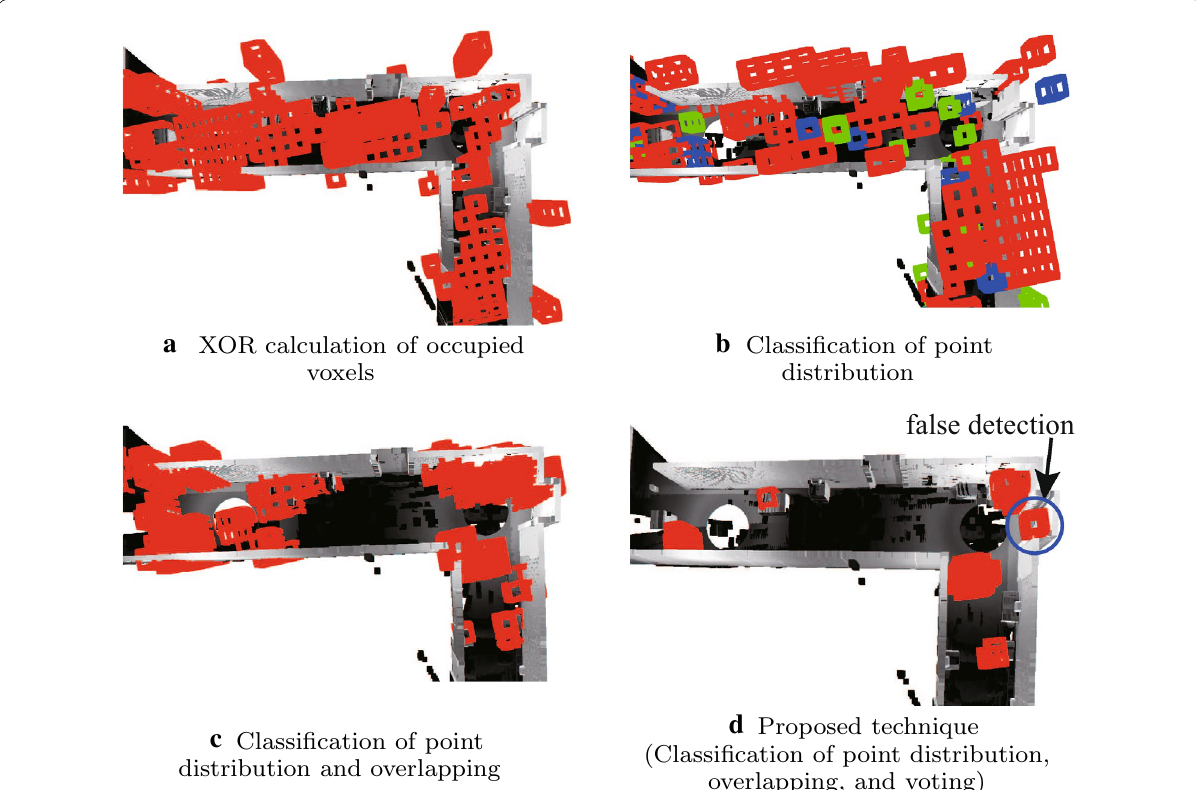
Fig. 9 Detected spatial changes (red) in a